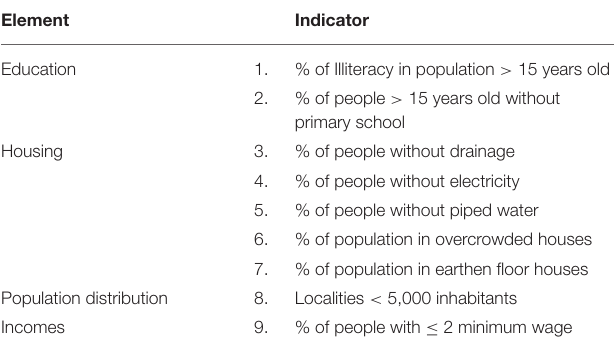
TABLE 1 | Elements that integrate the national index of marginalization CONAPO, 2010. Element